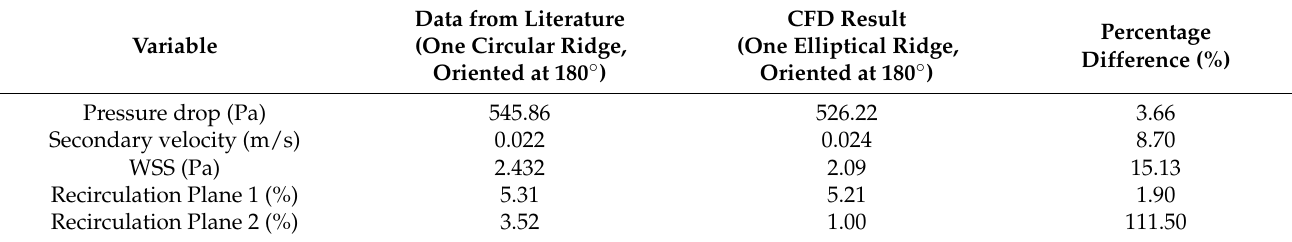
Table 2. Quantitative validation of simulation results by comparison of different variables from CFD simulation against data from the literature.